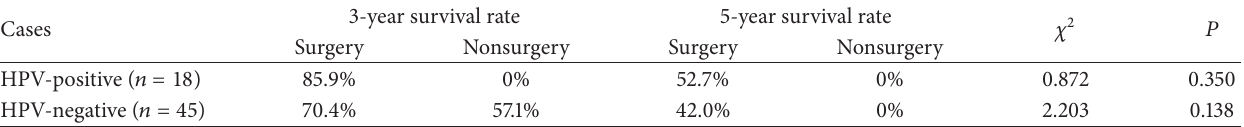
Table 2: The impact of HPV infection status on the prognosis of patients undergoing surgery or nonsurgical treatment.